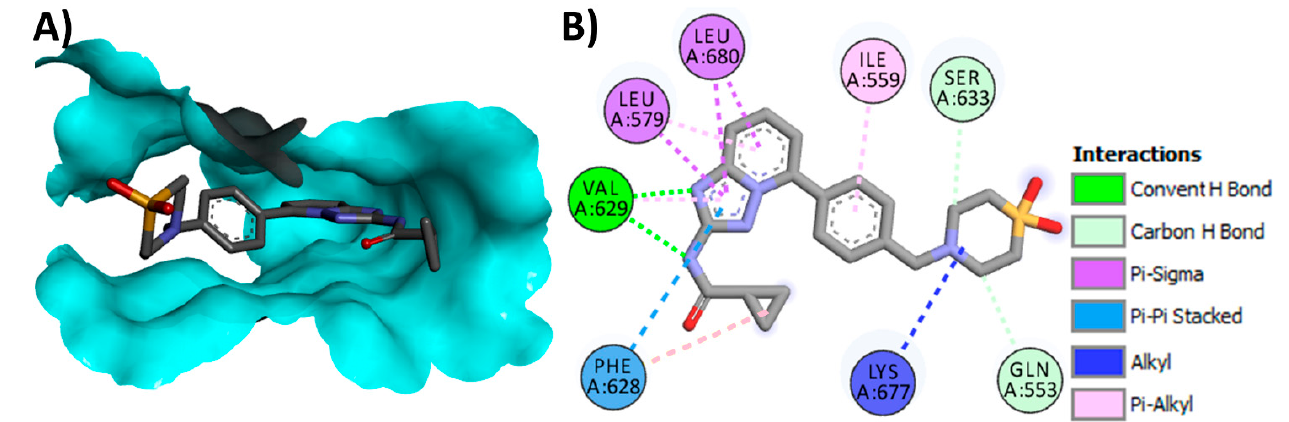
Figure 35. Binding modes of filgotinib (shown as sticks) into JAK2 JH2 (pdb: 5UT5): ( A ) 3D binding mode, receptor shown as a hydrogen bond surface; ( B ) 2D binding mode showing different types of interactions with JAK2 JH2; the figure was generated using Discovery Studio Visualizer